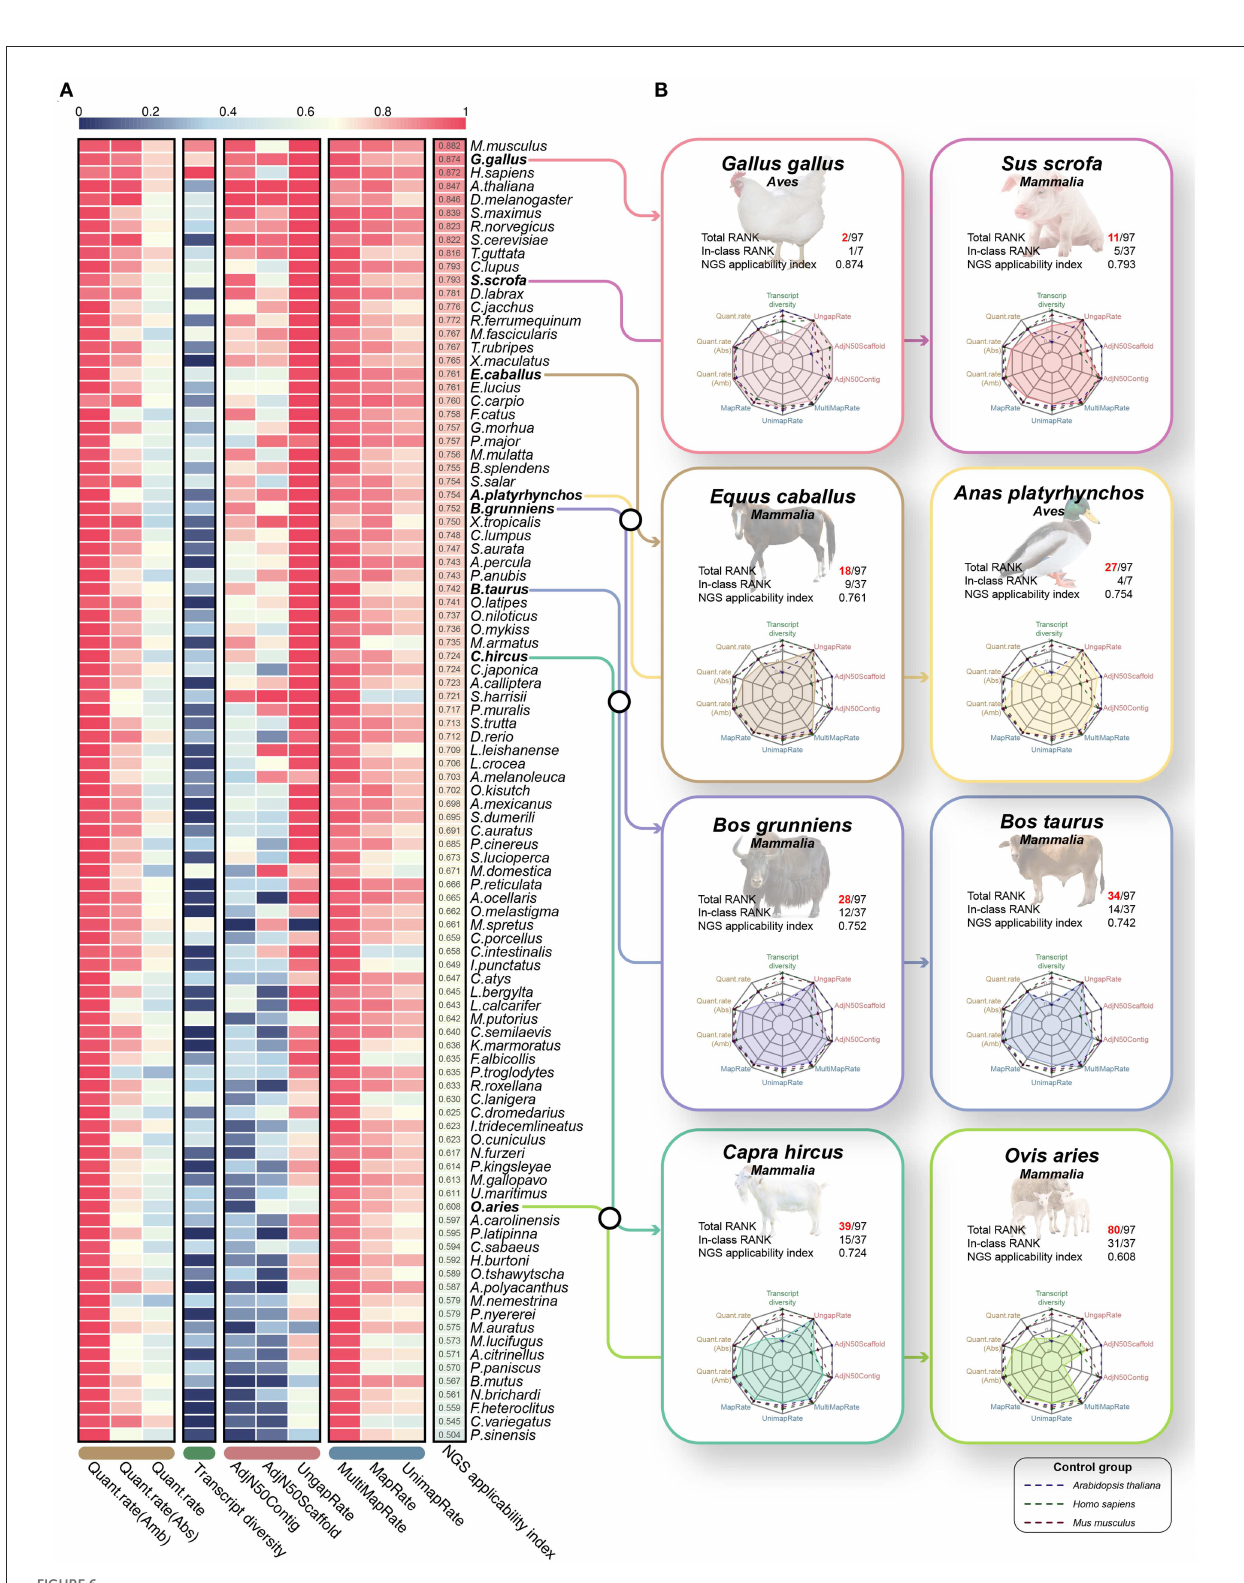
FIGURE6 Quality evaluation results of 97 species through the proposed NGS applicability index based on the 10 quality evaluation indicators verified through this study. (A) Heatmap for a total of 10 quality evaluation indicators selected through this study. The heatmap includes three assembly evaluation indicators and three performance indicators derived from the mapping process, which can relatively evaluate the quality of genomes. In addition, transcript diversity and three performance indicators derived from the quantification process are included to relatively evaluate the gene models. Finally, all 97 species were sorted in descending order through the NGS applicability index, which is the result of the weighted sum of these 10 quality evaluation indicators. All values have a scale of 0.0 to 1.0, and the closer to 1, the higher the quality. (B) Results of benchmarking quality evaluation of reference genome and gene annotation for 8 livestock